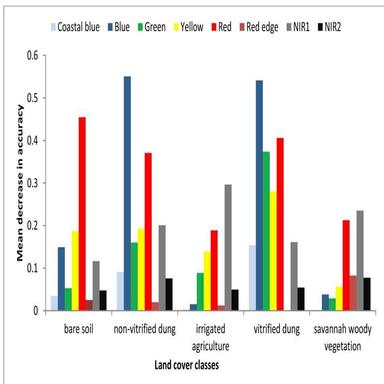
Histogram showing the importance of different WV2 bands in detecting each land cover class considered in the study.